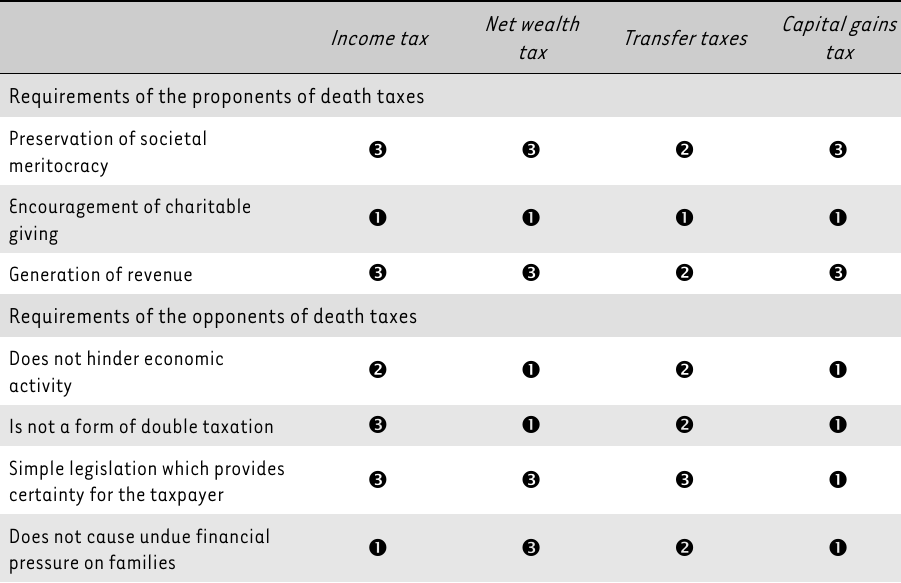
Criteria as established by proponents and opponents of death taxes